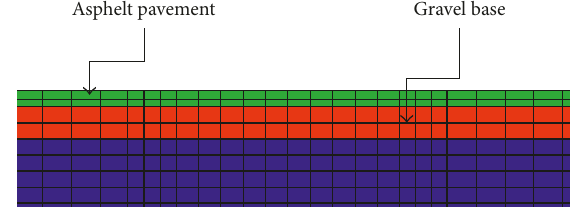
Figure 3: Road surface composition.